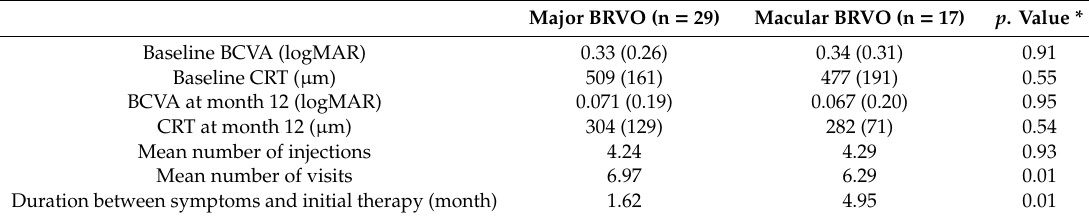
Table 2. Comparison of major BRVO and macular